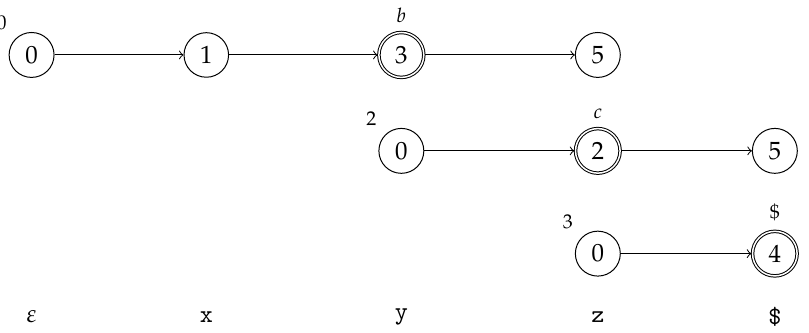
Figure 4. The scanner trace outlining the paths taken through the scanner automaton using the speci- fication Ξ in